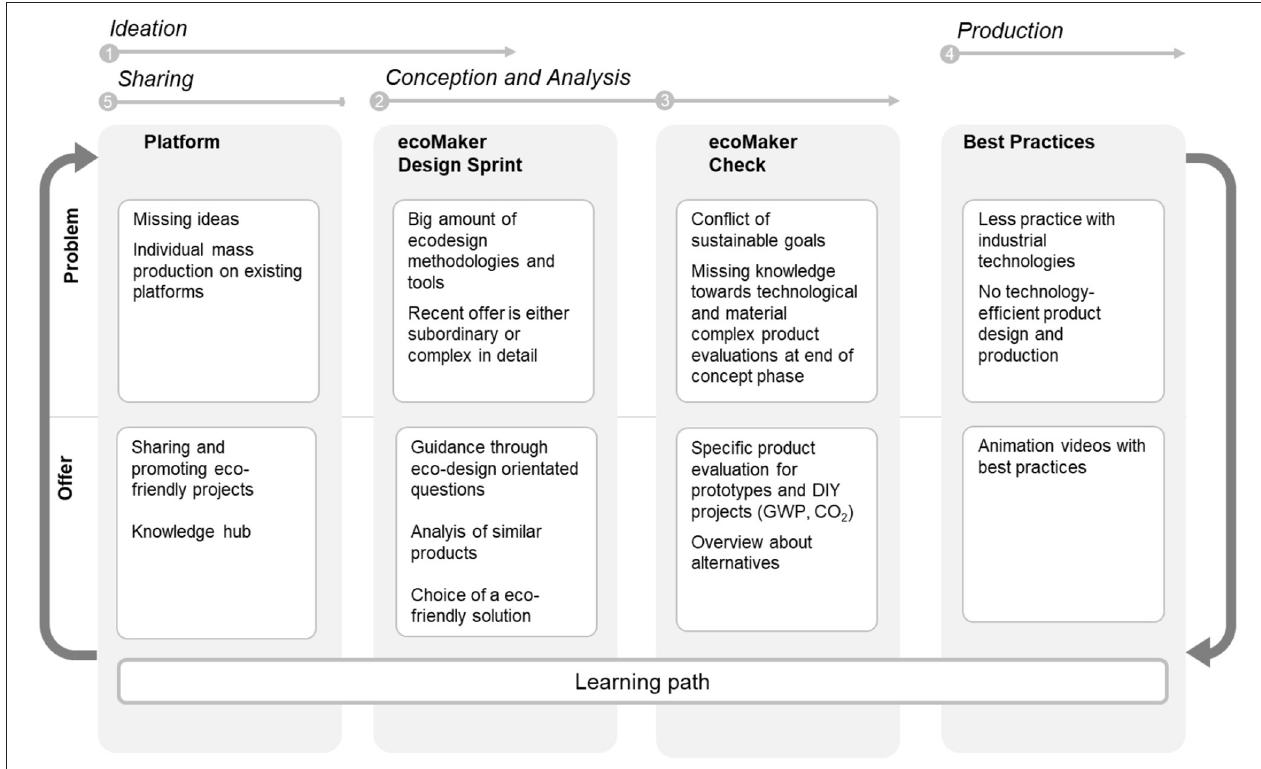
FIGURE 4 | Holistic ecoMaker concept for sustainable product development in makerspaces considering different lifecycle